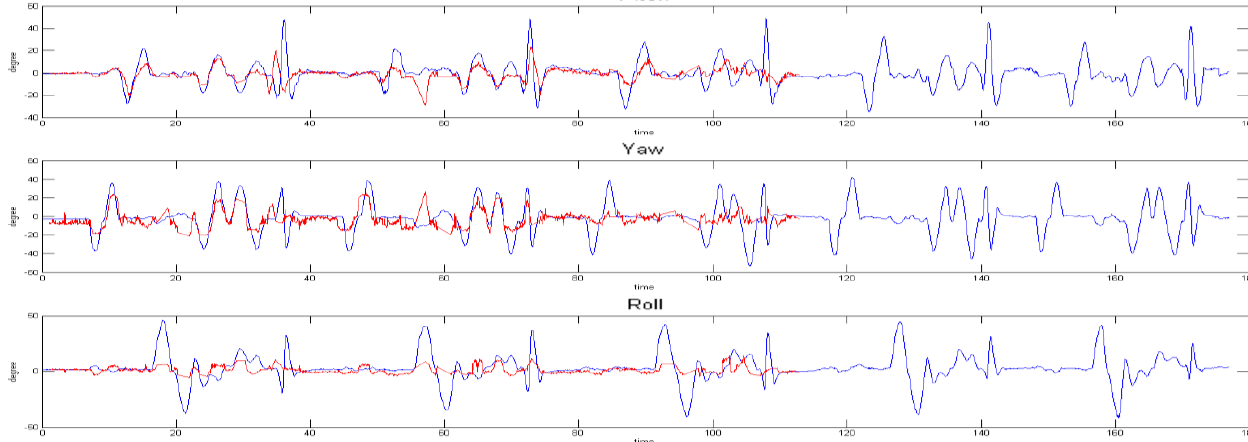
Figure 10. Reference: blue, 3DCloud: red. First row: pitch, second row: yaw, third row: roll. Tracking is lost for a distance greater than 2 meters for